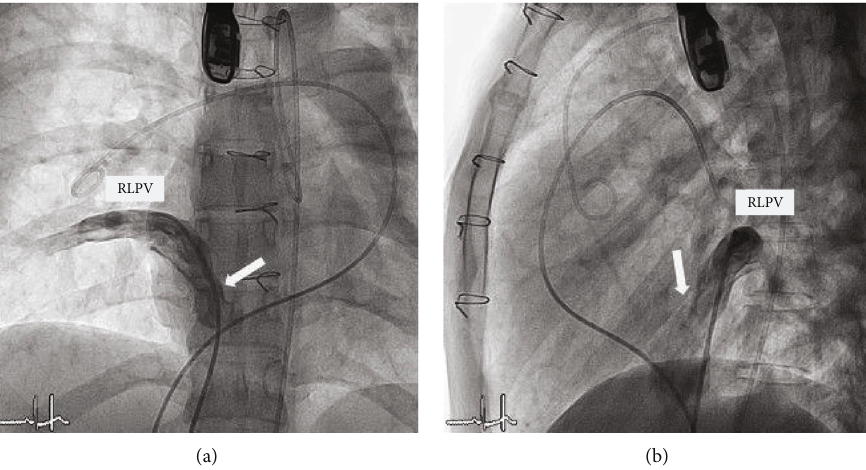
Figure 8: Right lower pulmonary vein (RLPV) angiography was performed simultaneous both (a) anterior view and (b) lateral view of the right atrium. The drainage of the RLPV into the right atrium (white arrow) was also shown in both views. (a) The decision was made to place the upper part of the covered stent and anterior and above the entrance of this RLPV (white arrow) to direct the pulmonary venous blood return to the left atrium.